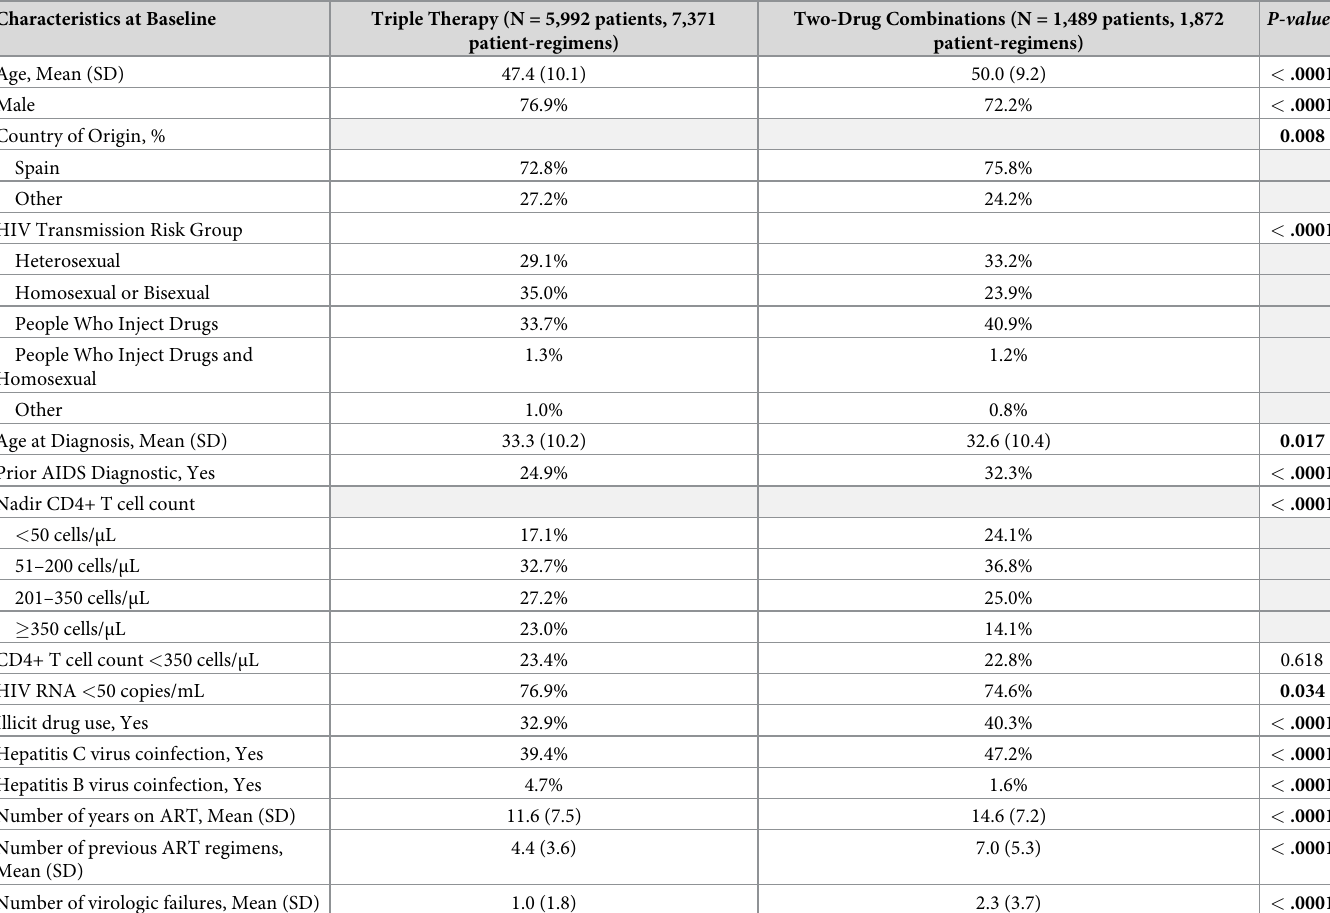
Table 2. Sociodemographic and clinical characteristics at baseline, overall